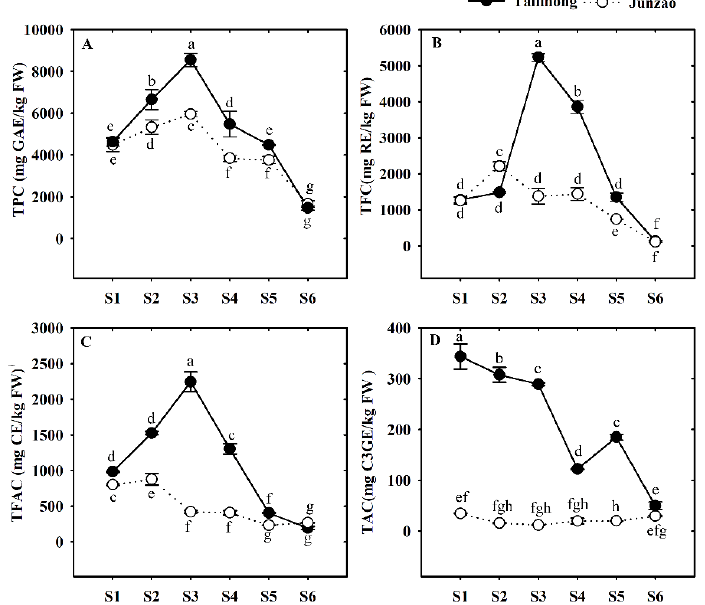
Figure 4. Total phenolics (TPC), total flavonoids (TFC), total flavanols (TFAC), and total anthocyanins